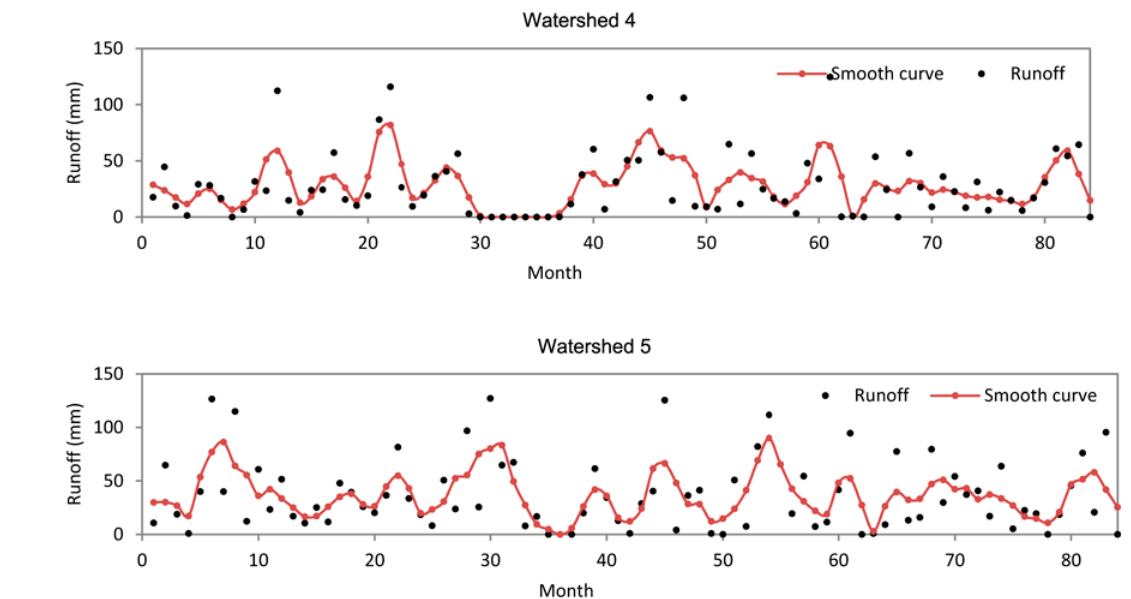
Fig. 7. Runoff and s moothing curve of five watersheds